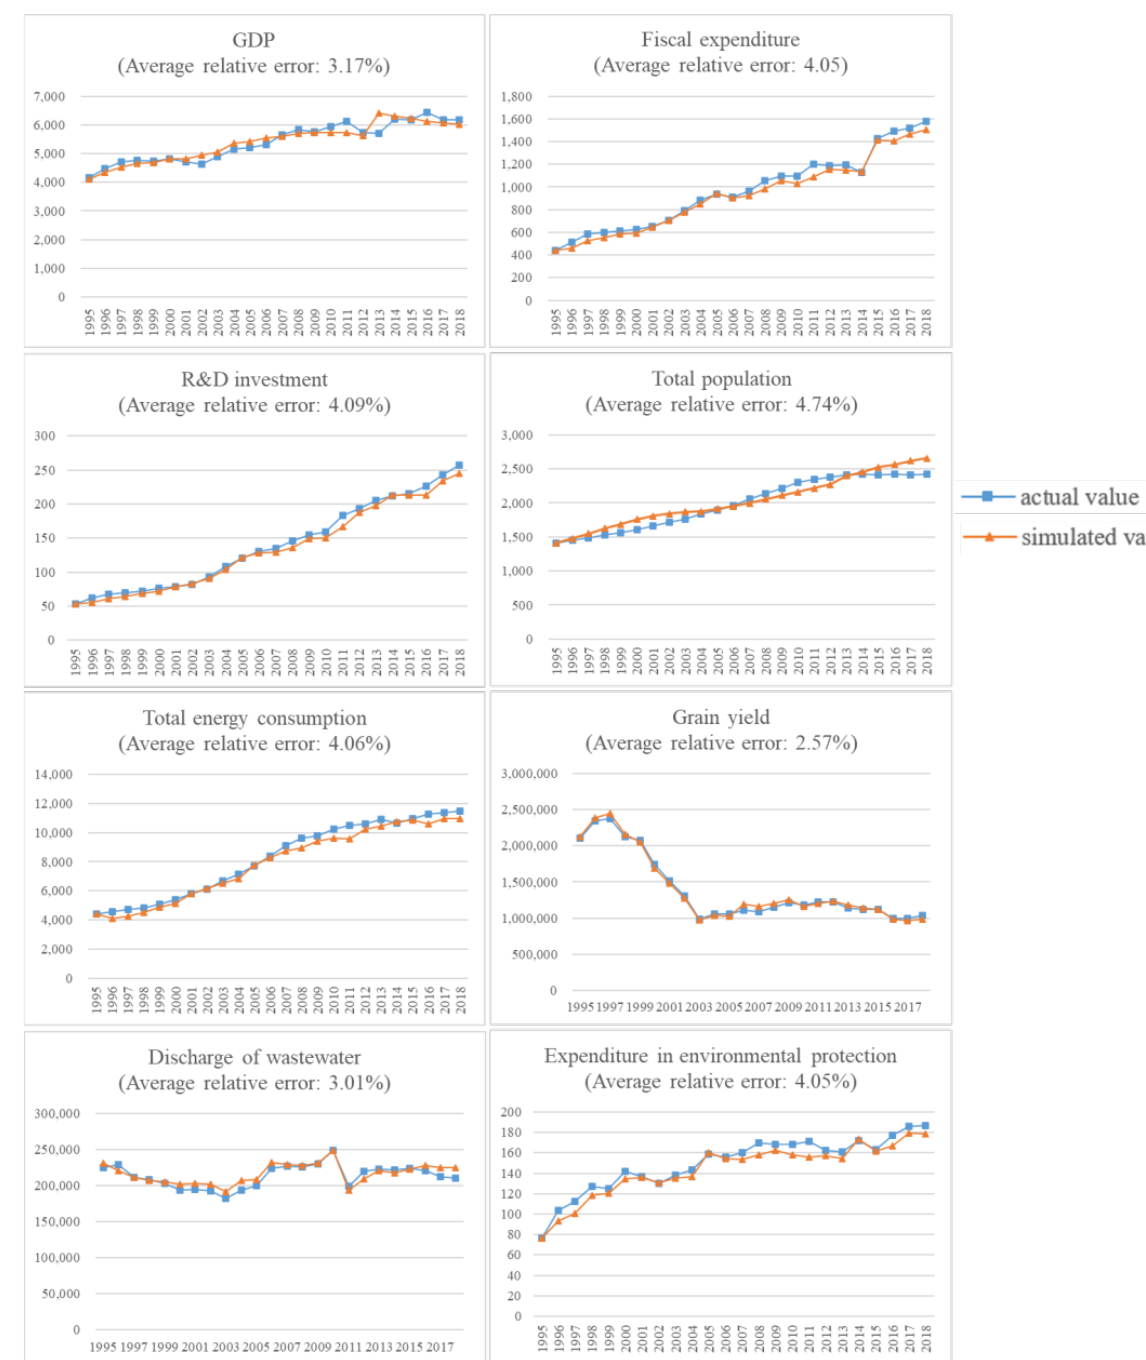
Figure 3. Average relative error of some key indicators in the model.